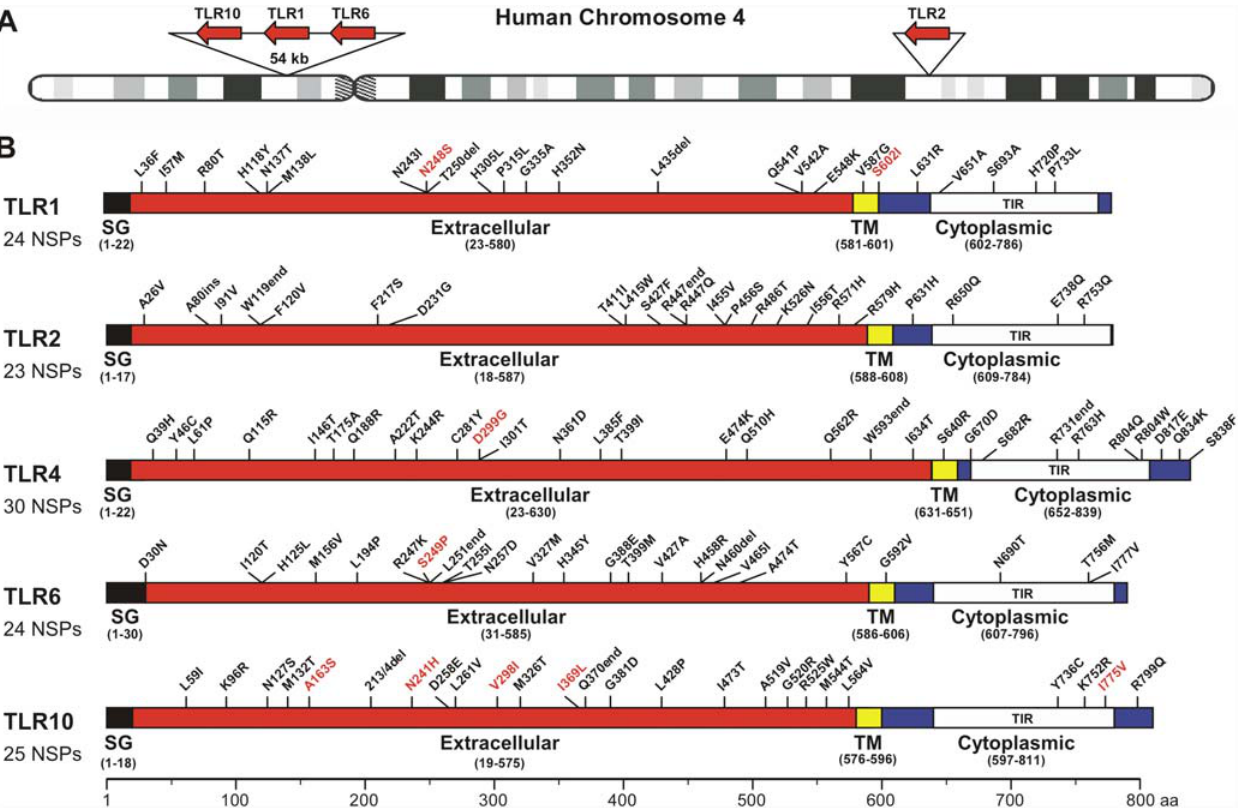
Figure 1. Schematic of the TLR proteins and sequence variants. ( A ) Schematic of human chromosome 4 showing location of TLR genes. ( B ) Summary of variants identified in five TLR proteins. Shown are all variant sites that would be made by the TLR alleles identified in either the TB patients or control subjects. Black, rare variant; red, variants that are common in all three ethnic groups analyzed. SG, signal peptide; TM, transmembrane domain; TIR, Toll/IL-1 receptor domain; NSP, nonsynonymous polymorphisms (includes nonsynonymous single nucleotide polymorphisms, nonsense mutations, and insertion and deletions). Numbers in parentheses denote amino acid residue positions.